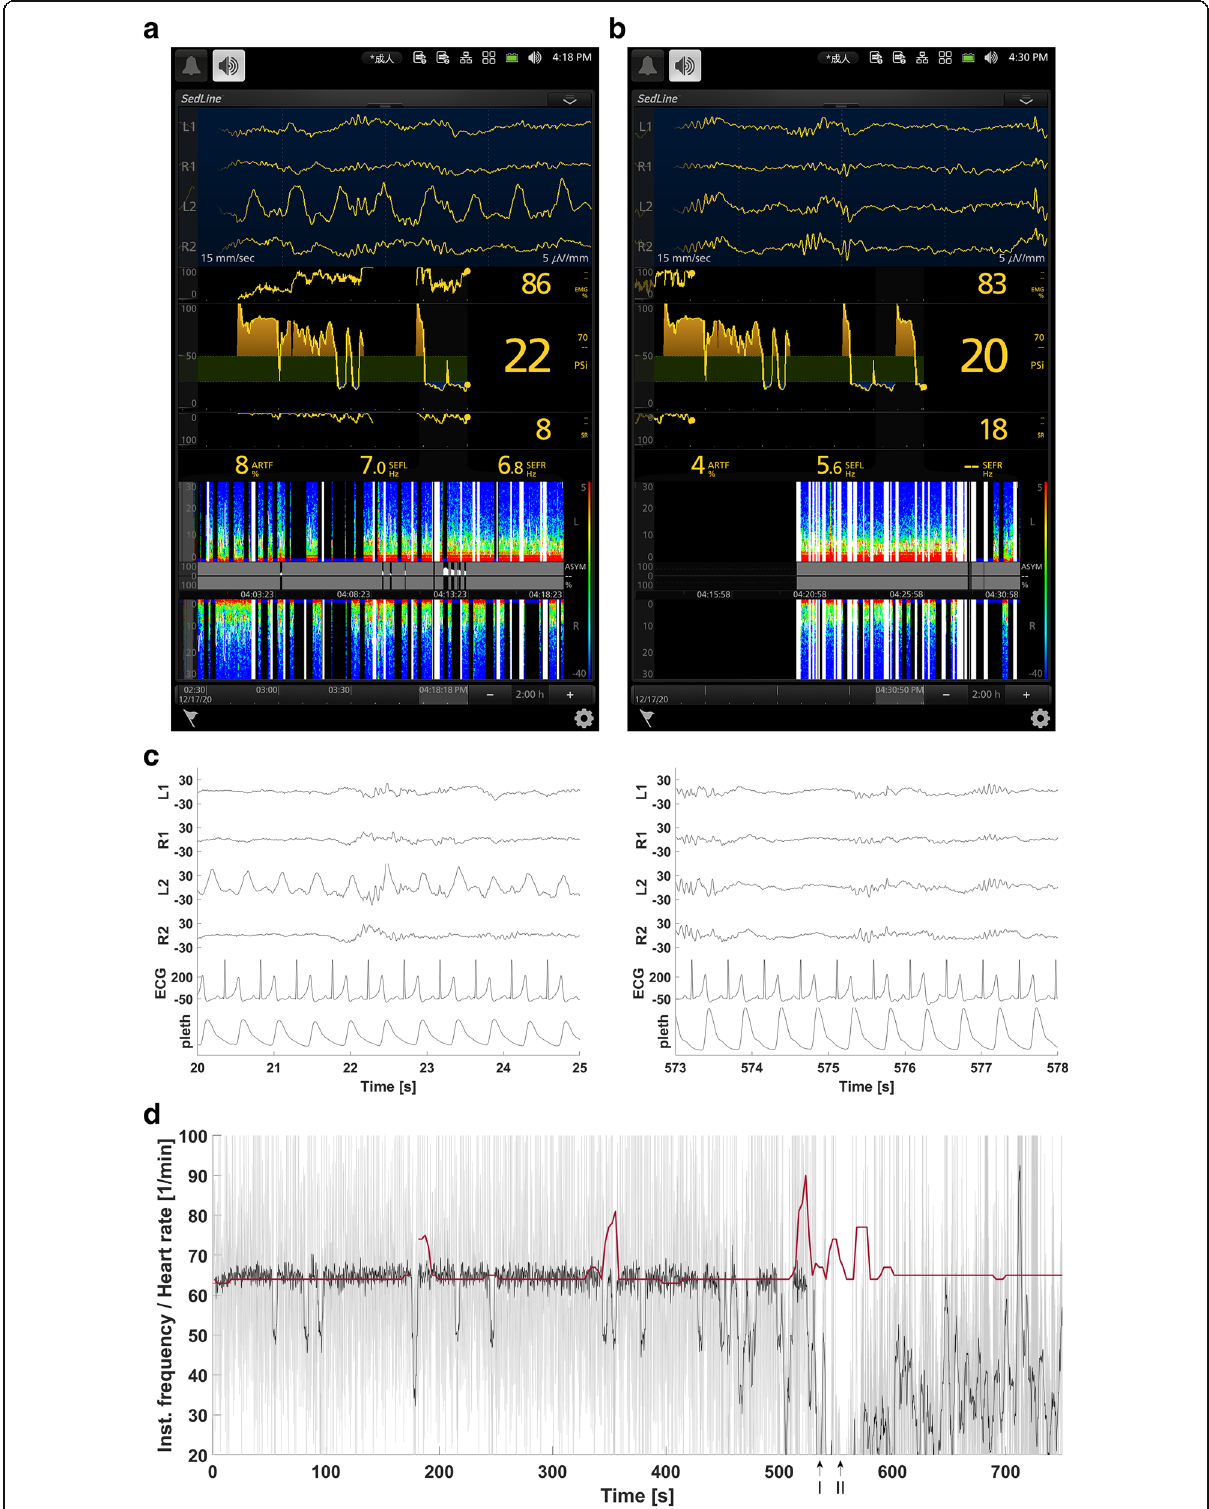
Fig. 1 (See legend on next